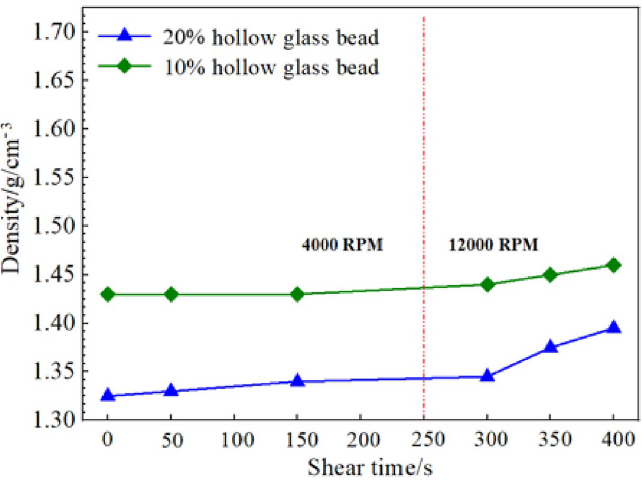
Figure 4. Variation of density of foamed cement slurry with shear speed.